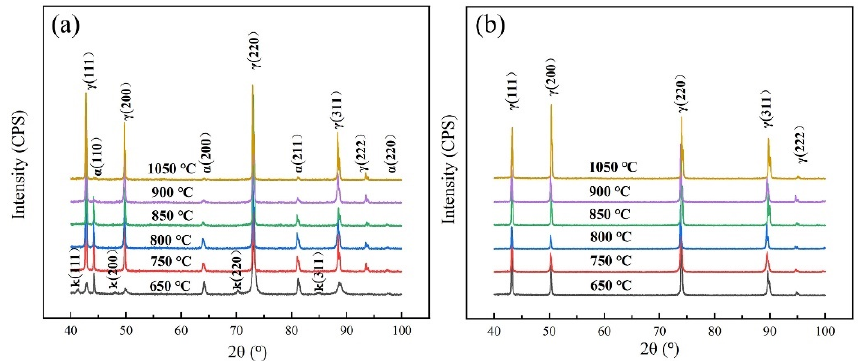
Figure 4. X-ray diffraction patterns of steels under different solid solution temperatures: ( a ) steel 1# and ( b ) steel 2#.